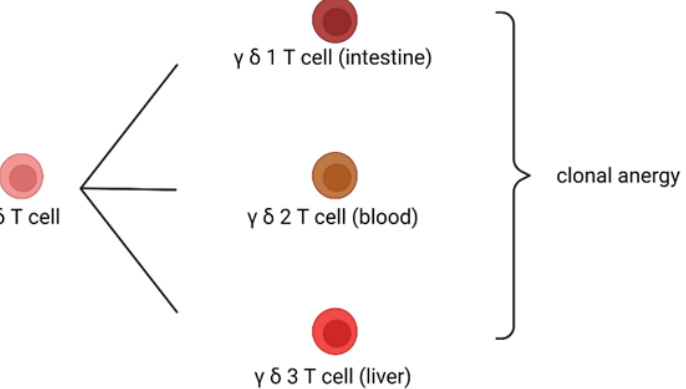
Figure 2. γδ T cells have three subclasses. γδ 1 T cells are located in the intestines, γδ 2 T cells are located in the blood, and γδ 3 T cells in the liver. They are located in immune tolerance organs to cause clonal anergy.